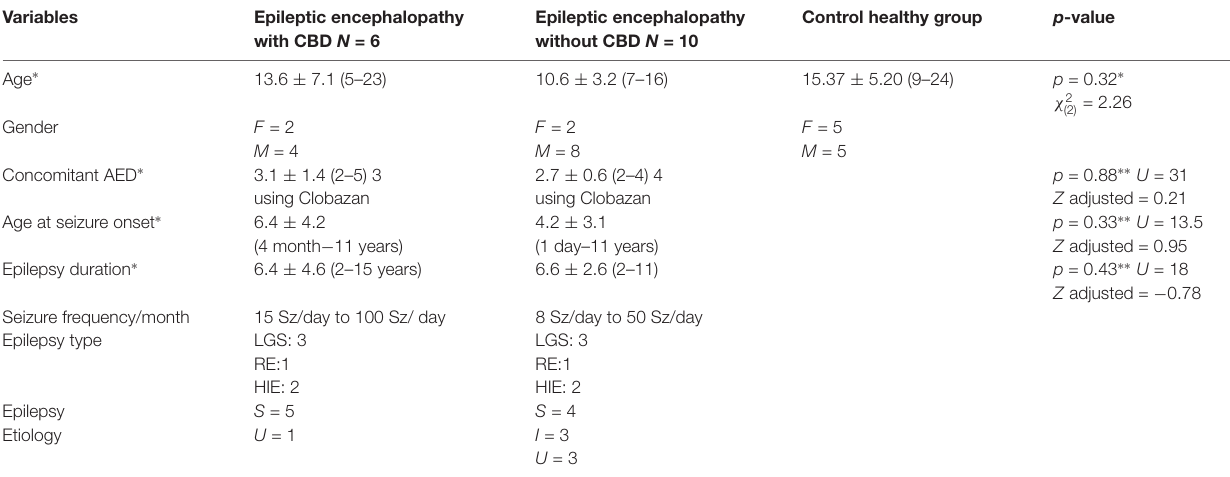
TABLE 1 | Demographic and clinical